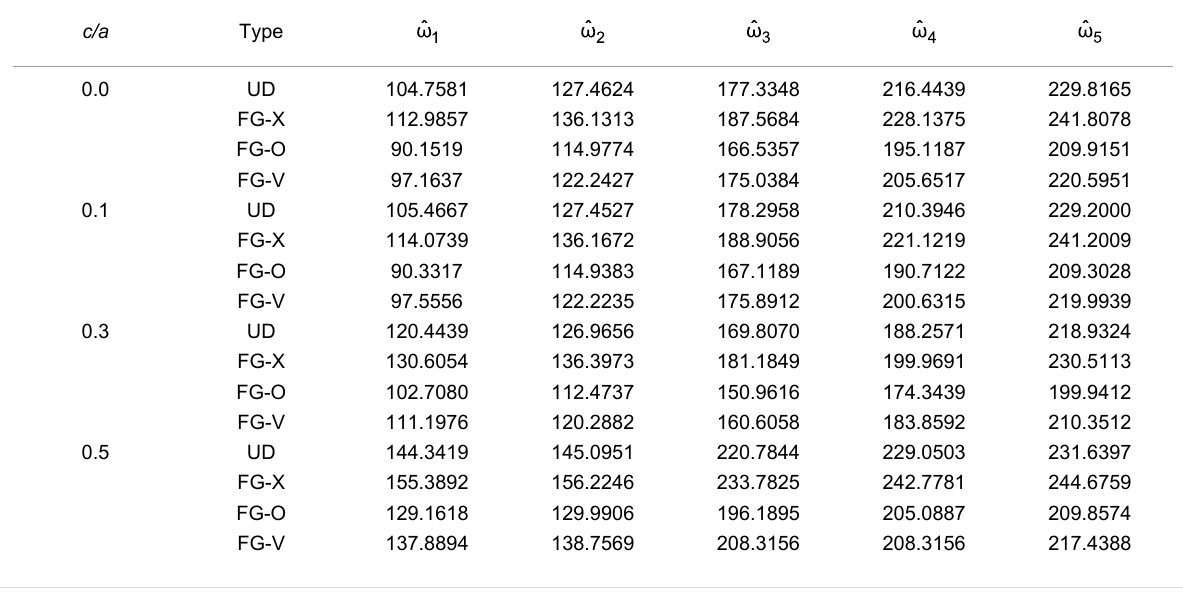
Table 8: First five natural frequency parameters for square FG-CNTRC CCCC plates with a centric cutout. Geometrical characteristics of the plate are a/b = 1, h/a = 0.05 and various c/a ratios. The volume fraction of CNTs is set equal to = 0.17.